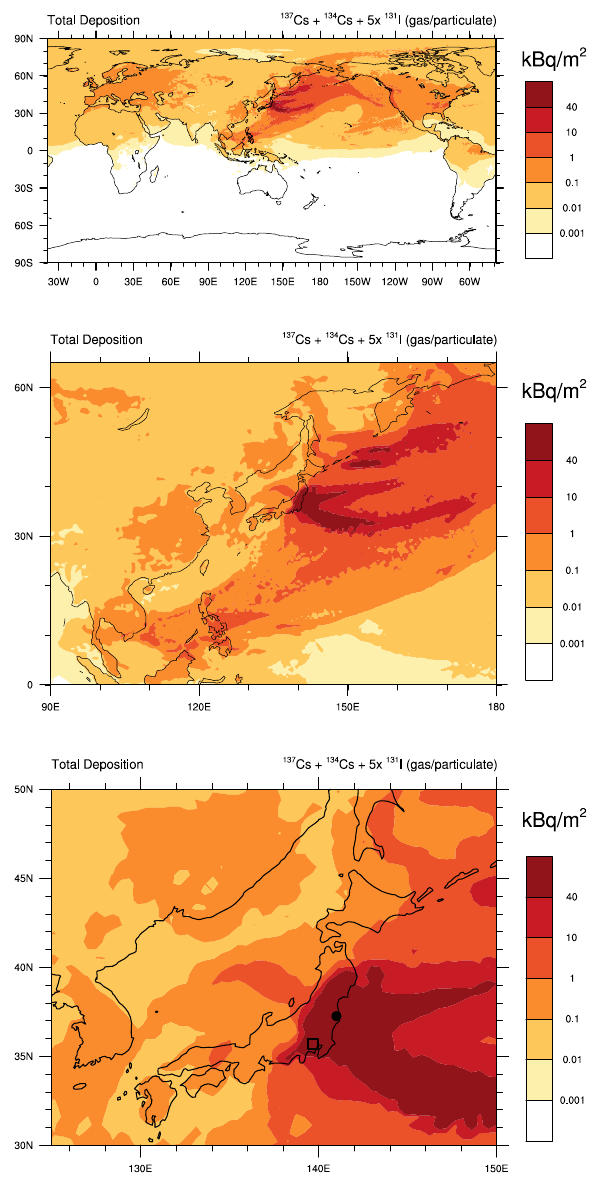
Fig. 8. Global (top), and regional (middle: Asia Pacific; Bottom: Japan) combined total deposition of 137 Cs (Stohl et al., 2012) and 131 I in Bq, based on a sensitivity simulation with 5 times enhanced 131 I emissions (750PBq; Chino et al., 2011), also including 134 Cs and particulate 131 I deposition scaled to 137 Cs. The black point marks the location of the Fukushima nuclear power plant and the rectangle the Tokyo metropolitan area. Contours are on a logarith- mic scale. The 40kBqm − 2 contour lines signify areas that received total deposition greater than the contamination activity level defined by the International Atomic Energy Agency (IAEA) (2005, 2009).